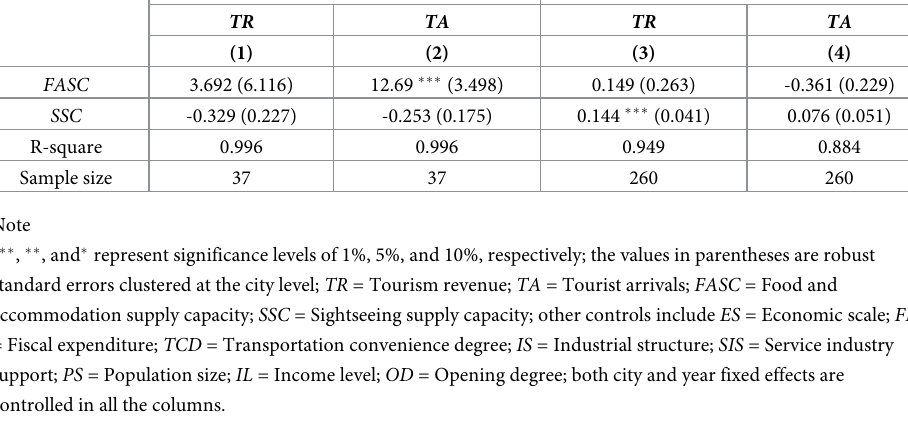
Table 6. The mechanism of HSR impact on tourism development. Node cities